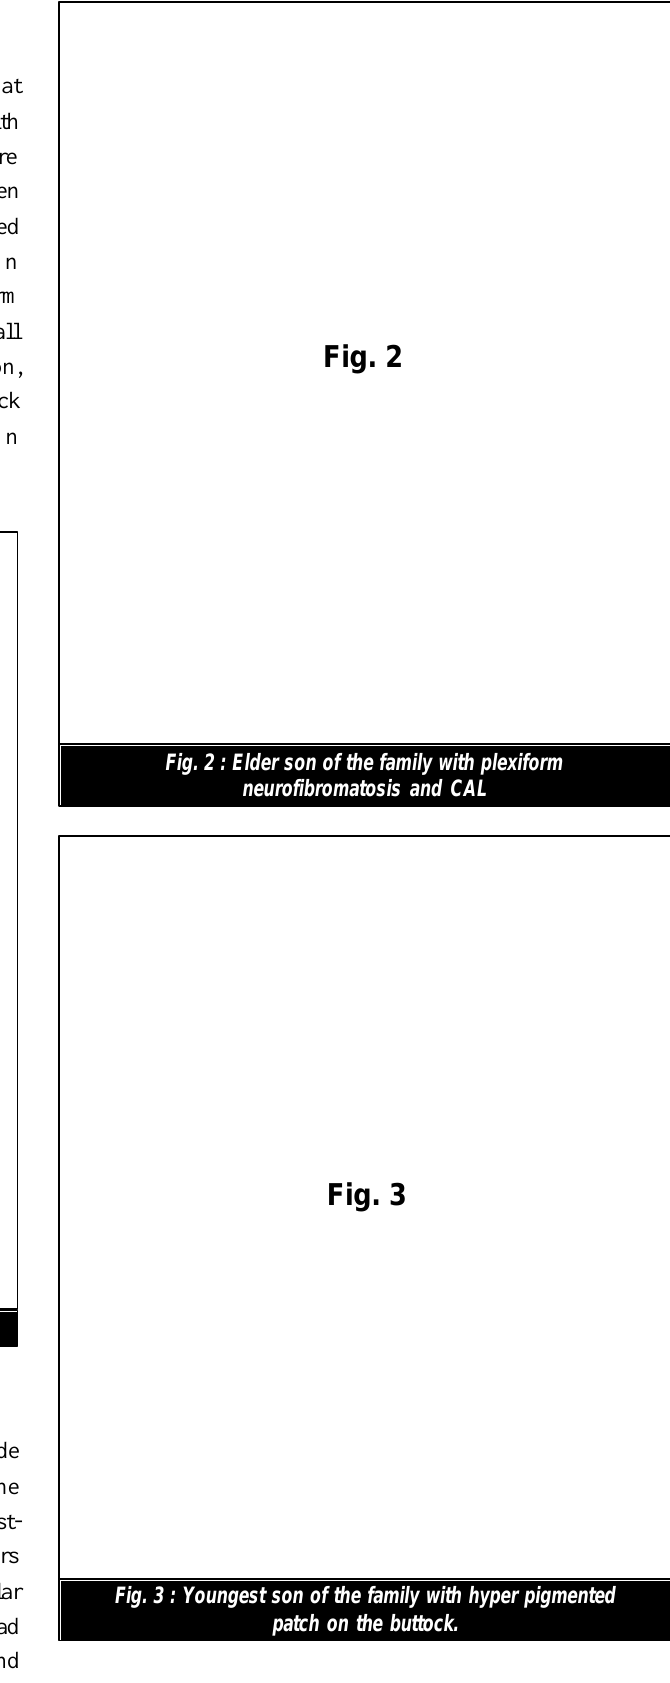
Fig. 3 : Youngest son of the family with hyper pigmented patch on the